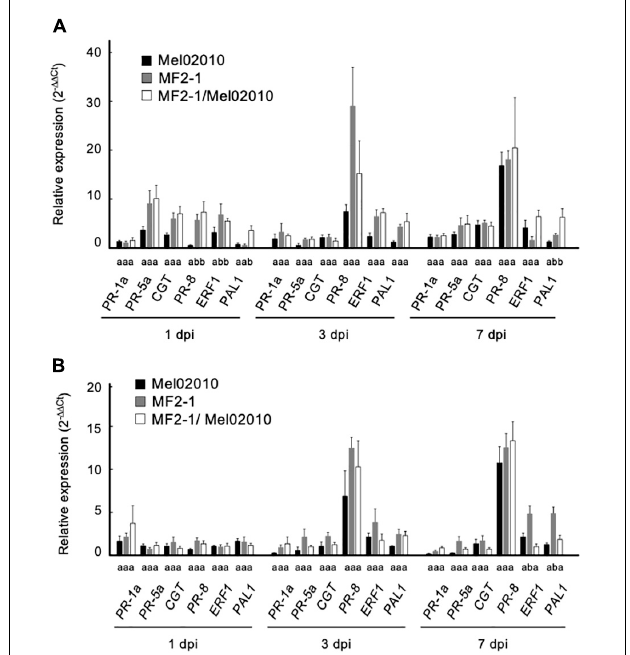
FIGURE 5 | Transcription levels of defense-related genes in melon seedlings inoculated with (cid:49) FOW2 strain. Roots of melon seedlings were dipped in a conidial suspension (1 × 10 8 conidia/mL) of (cid:49) FOW2 strain MF2-1, and seedlings were planted in soil uninfested (MF2-1) or infested with the wild-type strain Mel02010 (1 × 10 5 conidia/g soil) (MF2-1/Mel02010). Control seedlings were immersed in water and planted in Mel02010 infested soil (Mel02010) or uninfested soil. Seedlings were removed from soil 1, 3, or 7 dpi, and total RNA was extracted from roots (A) and aboveground parts (B) for quantitative real-time PCR analyses. Raw data were analyzed using the 2 − (cid:49)(cid:49) Ct method. Data were normalized against the actin gene, and those of uninoculated melon seedlings was set to 1.0. Error bars indicate the standard errors calculated from three independent inoculation experiments with two replicates. Columns with different letters indicate that means differed significantly at P ≤ 0.01 in the Tukey–Kramer multiple range